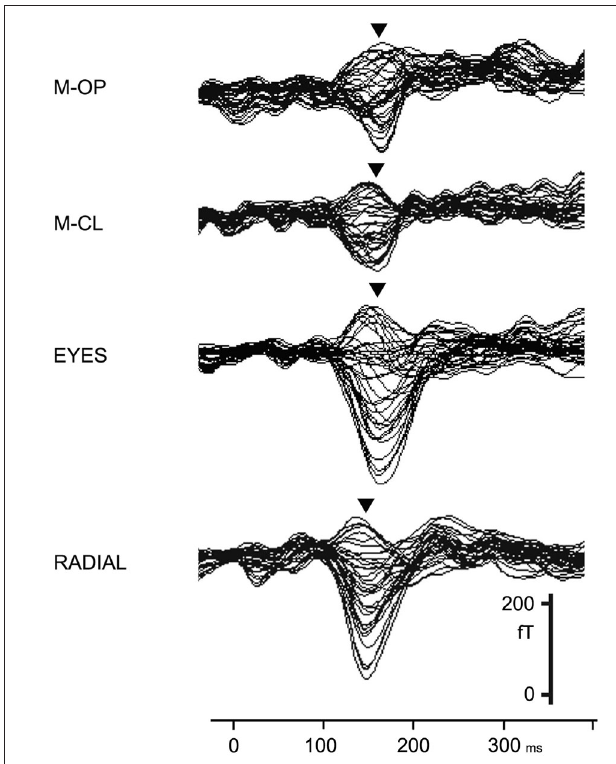
FIGURE 2 | Right hemisphere MEG activity shown in a 37-channel superimposed display for all conditions in a representative subject (adopted from Miki et al.,